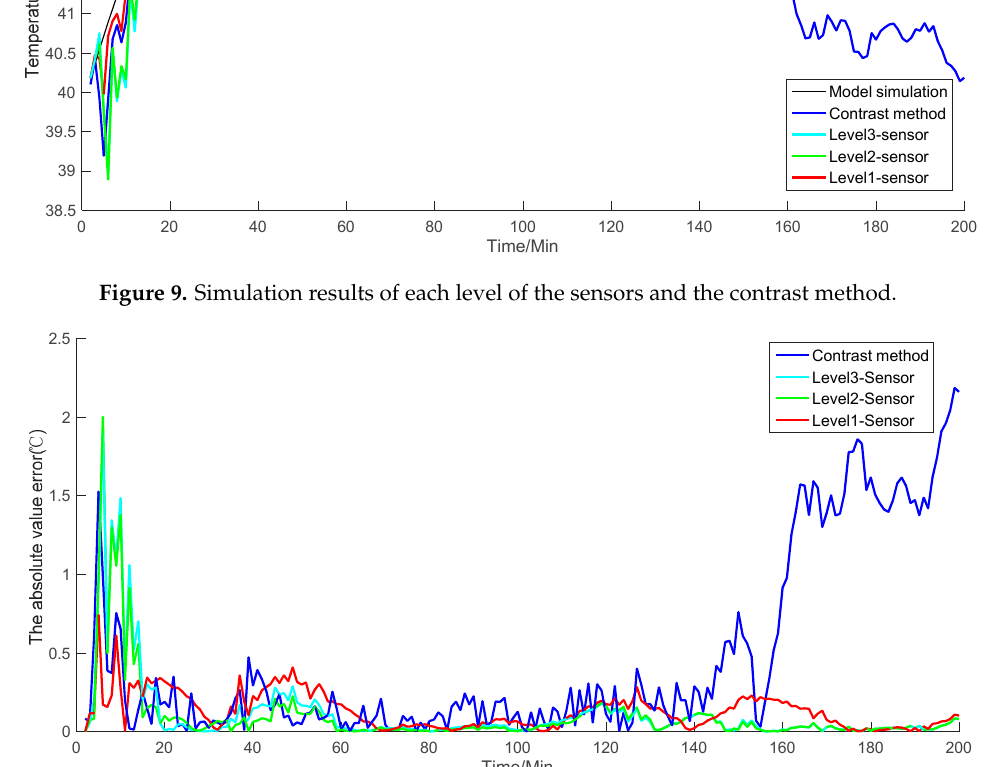
Figure 10. Absolute error of each level of the sensors and the contrast method.